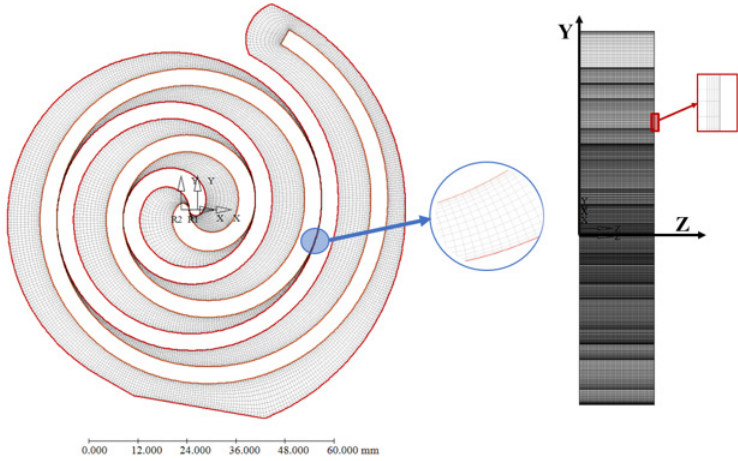
Figure 4. Structured mesh of the scroll working